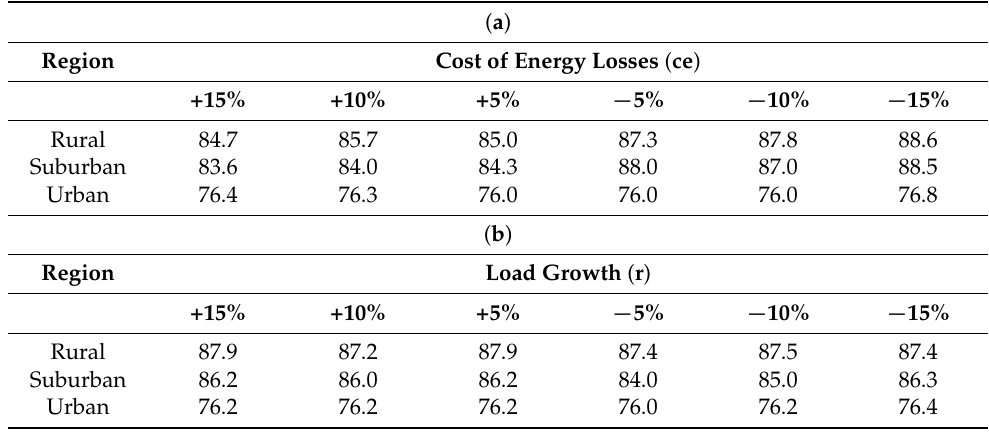
Table 10. Sensitivity analysis of economical hosting capacity in the cost analysis of three Finnish distribution networks by changing the cost of energy losses (ce) and load growth (r) by a factor of ± 5%, ± 10%, and ± 15%. ( a ). HC change with respect to the cost of energy losses deviation. ( b ). HC change with respect to load growth